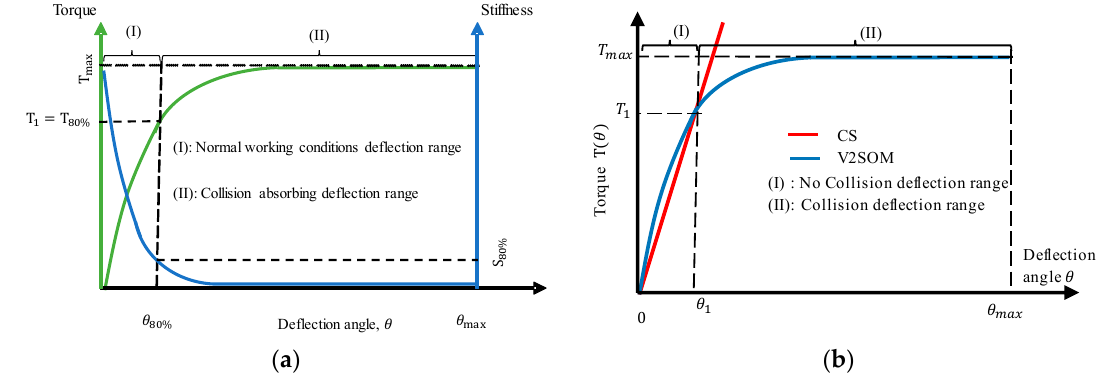
Figure 8. ( a ) V2SOM working modes; ( b ) statically equivalent V2SOM and constant stiffness (CS) profiles.